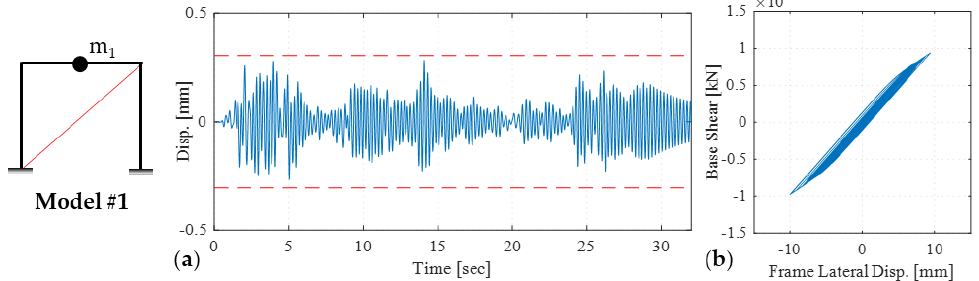
Figure 6. ( a ) Small-scale brace displacement response history along with equivalent brace yield displacement band (red dashed line), and ( b ) global frame force – displacement response for Model #1.